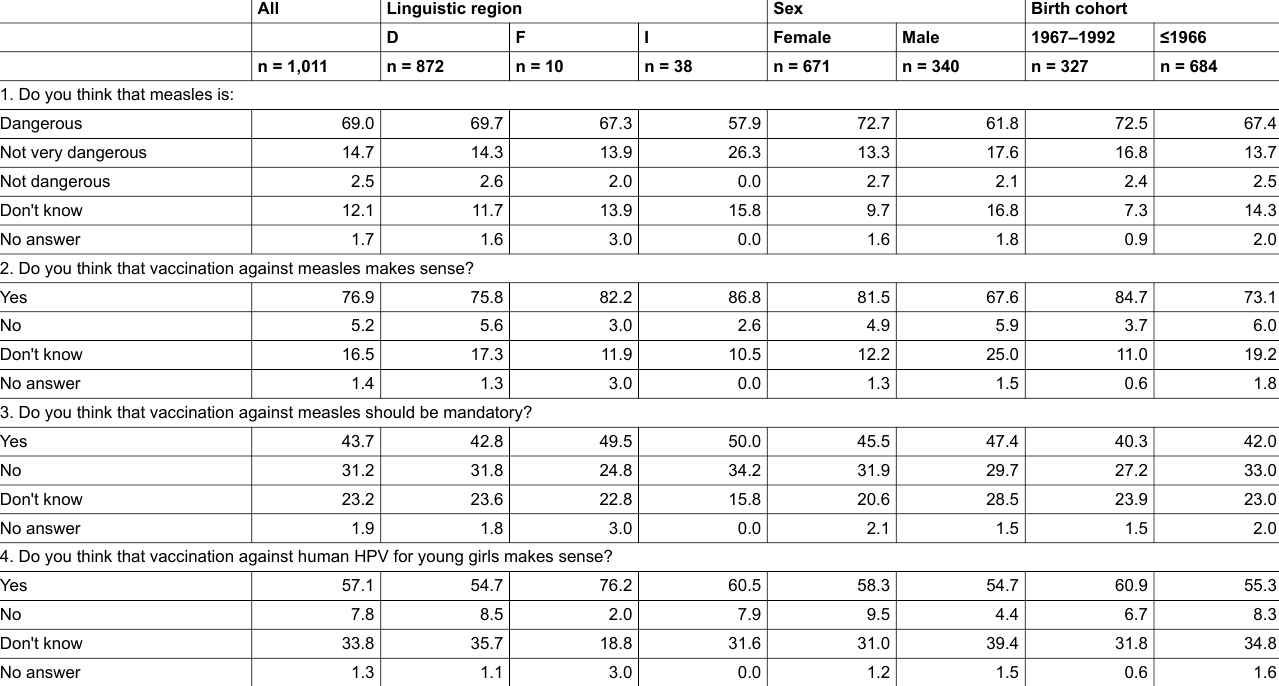
Table 3: Distribution (%) of the responses to the questionnaire according to linguistic region, sex and age group. D, F and I are the German-, French- and Italian-speaking regions, respectively.